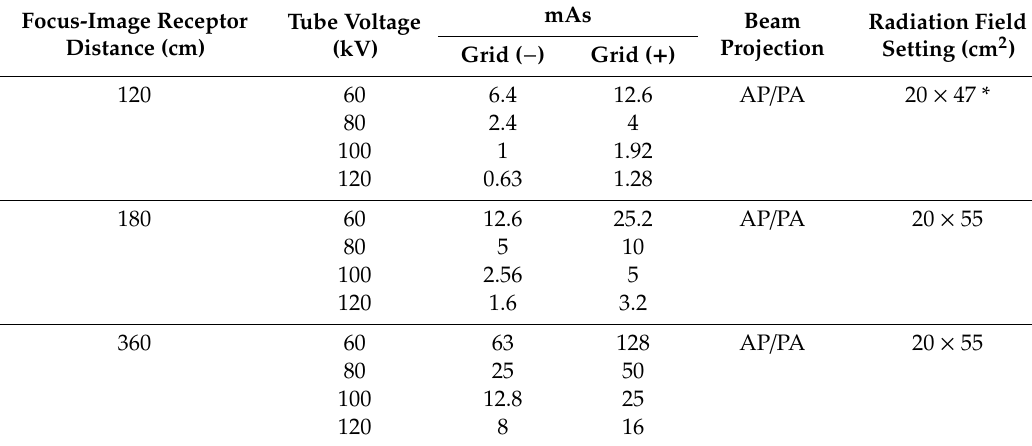
Table 1. Geometry and exposure settings of the full-spinal radiographs. (* A limitation of the X-ray system used in our study is that the radiation field setting must be 47 cm when the focus-image-receptor distance is 120 cm. A radiation field setting of 55 cm is not possible if the focus-image-receptor distance is 120 cm.). AP: anteroposterior, PA: posteroanterior.